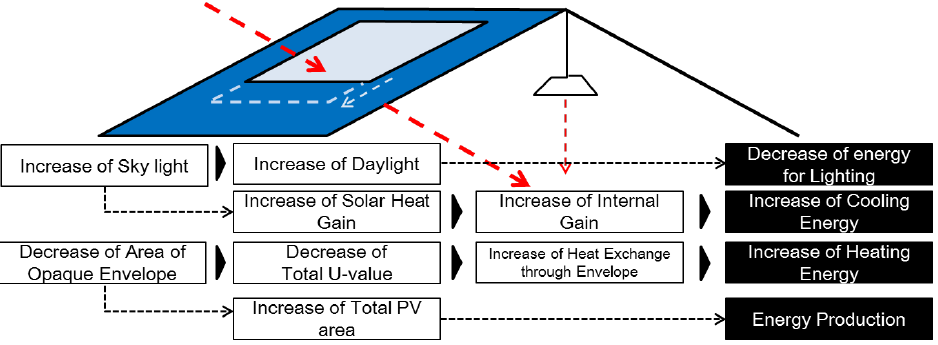
Figure 9. Co-Relationship between Energy Saving Strategies and Energy Consumption.